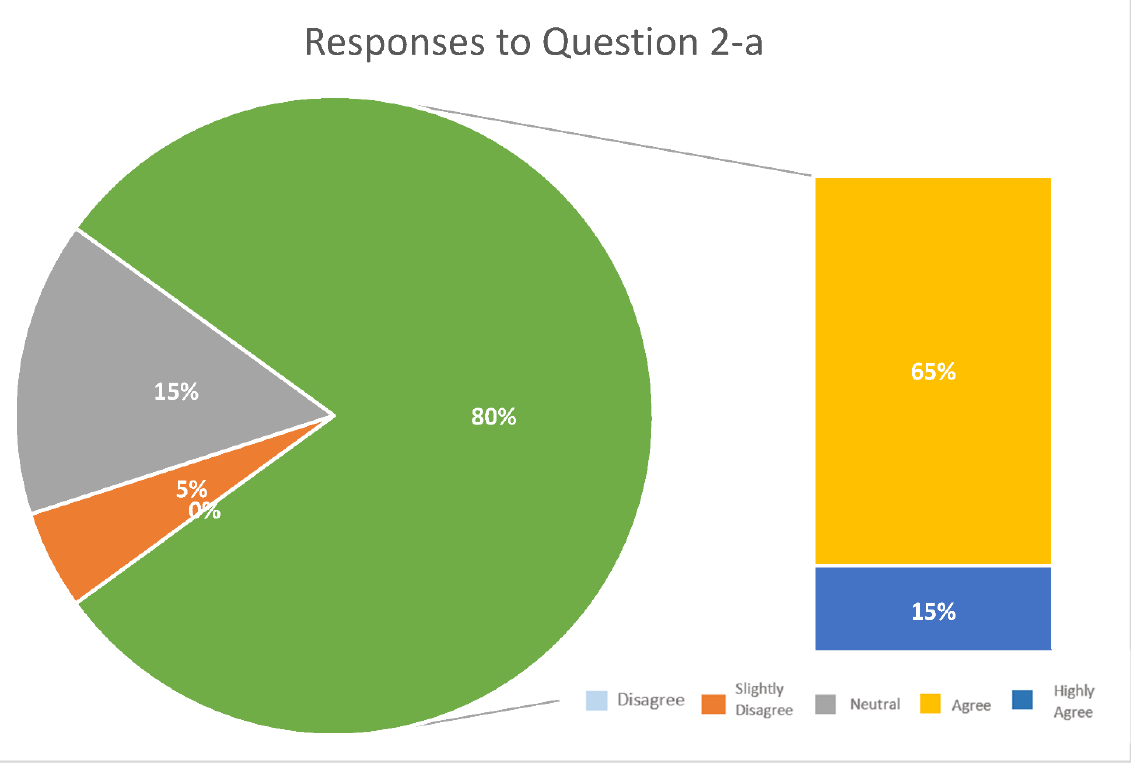
Table 5. Responses to Question 3-a. Mean